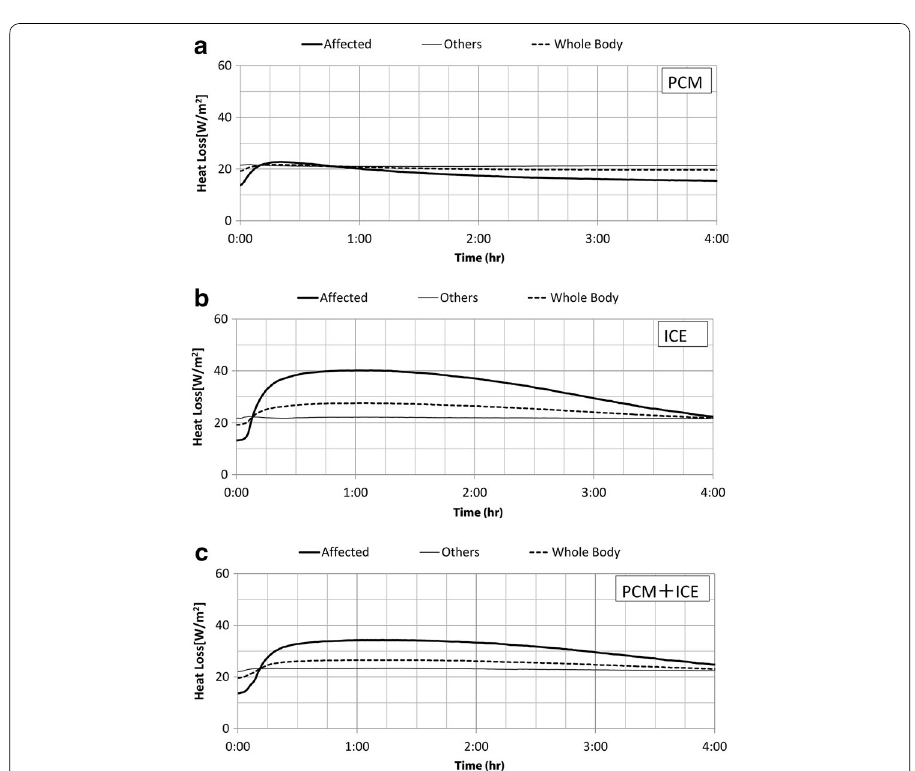
Fig. 7 Heat loss of VEST. a PCM, b ICE, c PCM